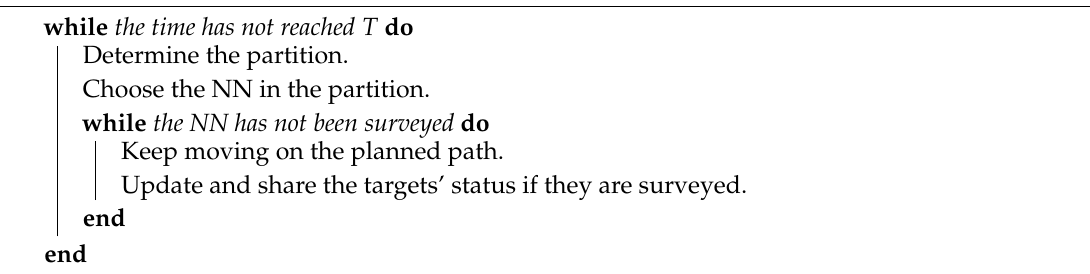
Algorithm 3: The navigation algorithm running at a UAV in the